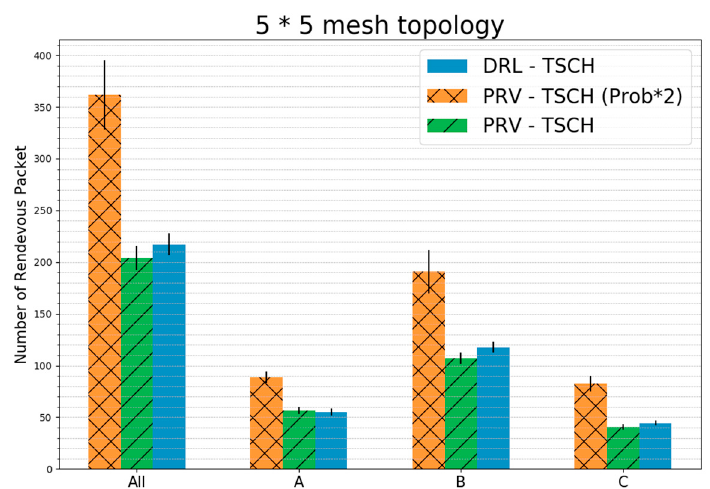
Figure 17. Average Rendezvous Packet Transmission before Synchronization in a 5 × 5 Mesh Topology (standard error).